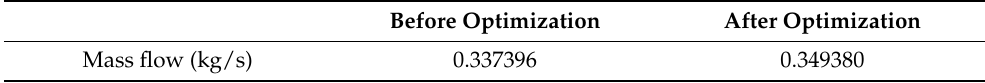
Table 7. Total air mass flow of guide channels before and after optimization.